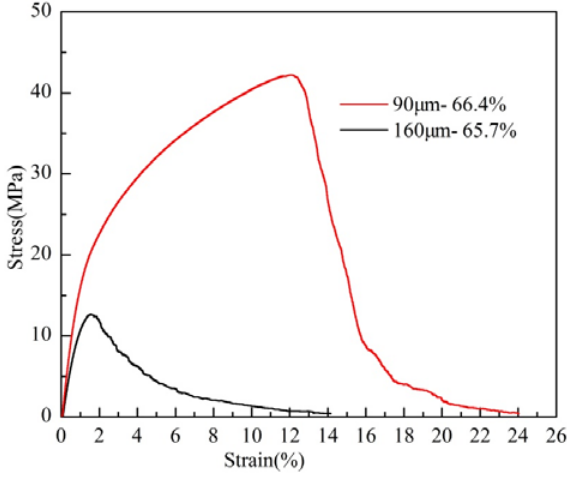
Figure7. Uniaxial tensile stress-strain curves of the PTWMs with different wire diameters.